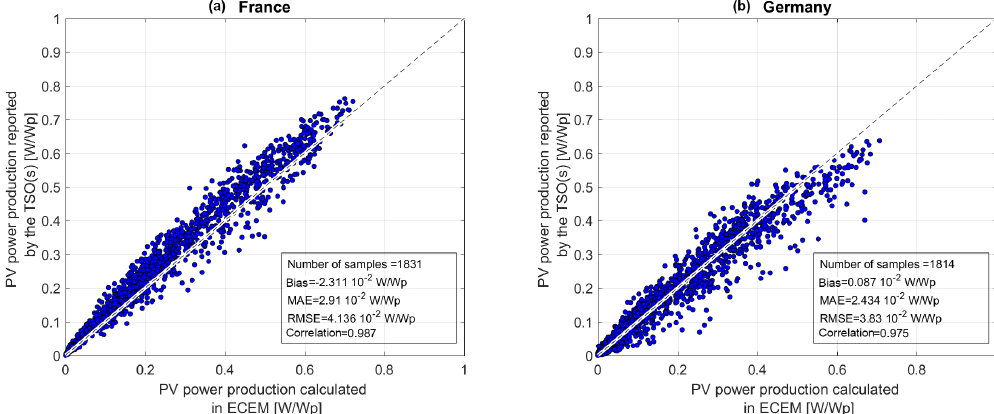
Figure 7. Scatter plots of the TSO data against model outputs for France (a) and Germany (b) for the calculation based on the spatially resolved installed capacity of the year